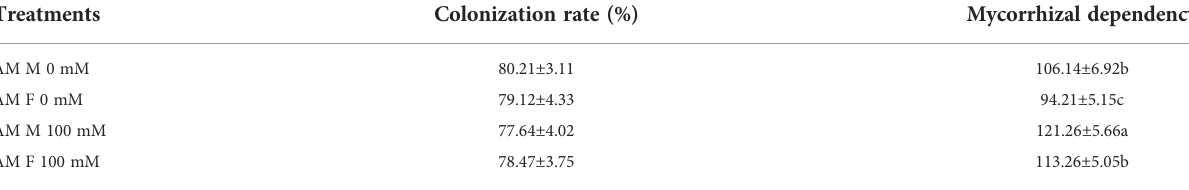
TABLE 2 Colonization rates and mycorhizal denpendence of Populus euphratica under different salt conditions.